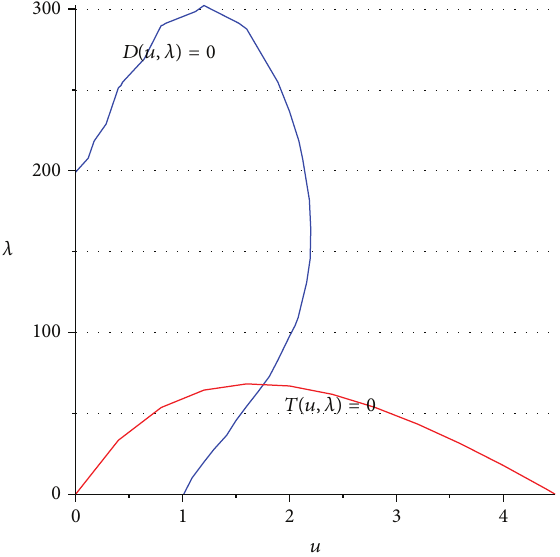
Figure 5: The graph of 𝑇(𝑢,𝜆) = 0 and 𝐷(𝑢,𝜆) = 0 , where 𝑑 1 = = 0.004 , 𝑒 = 0.5 , 𝑎 = 1 , 𝑛 = 5 , 𝑚 = 1 , 𝜇 = 0.4 , 𝑟 = 2 , and 0.001 , 𝑑 2 𝐾 = 10 . In this case, 𝑢 ∗ > 𝑚